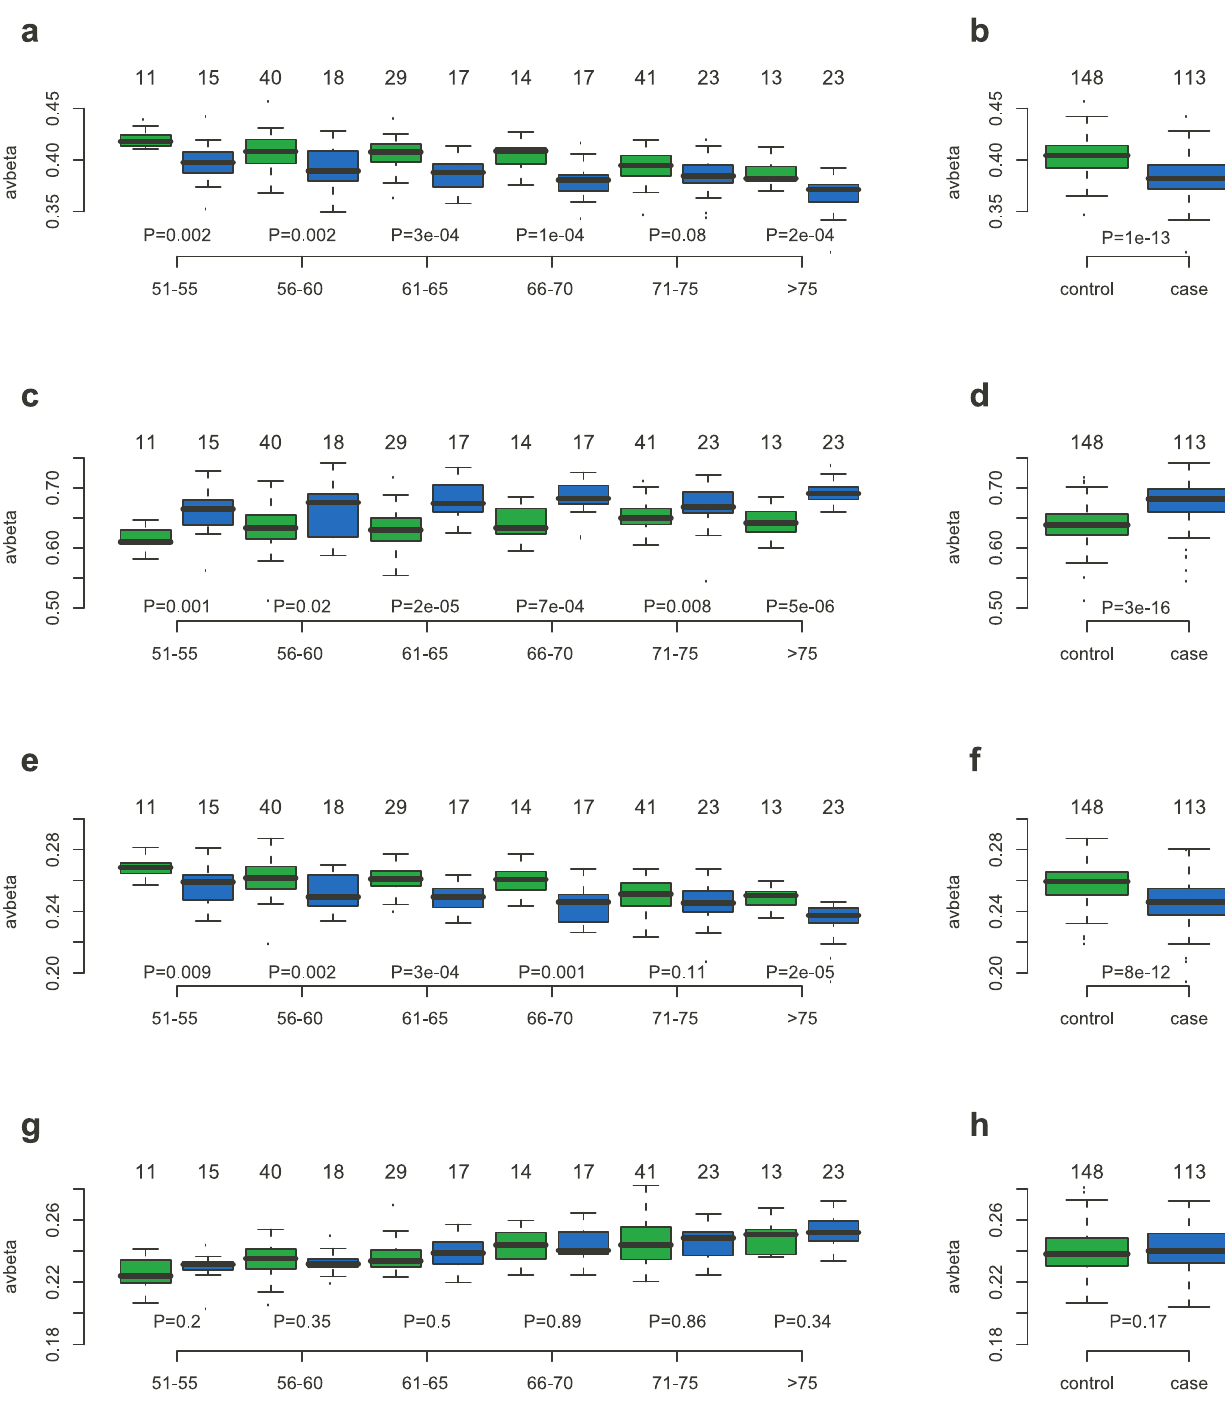
Figure 3. Age-dependent methylation patterns are associated with ovarian cancer. Average methylation patterns of age-associated CpGs selected through supervised analysis. ( a–b ) age hypomethylated niCpGs. ( c–d ) age hypermethylated niCpGs. ( e–f ) age hypomethylated iCpGs. ( g–h ) age hypermethylated iCpGs. ( a,c,e,g ) Average methylation (y-axis) of controls (green) and cases (blue) for each of the six age groups (x-axis) (50– 55,55–60,60–65,65–70,70–75, . 75). ( b,d,f,h ) Average methylation versus disease status (all age groups combined). All P-values are from a two-tailed Wilcoxon rank sum test. In all panels, we give the numbers of samples in each group above the corresponding boxplot. Cases are pre-treatment